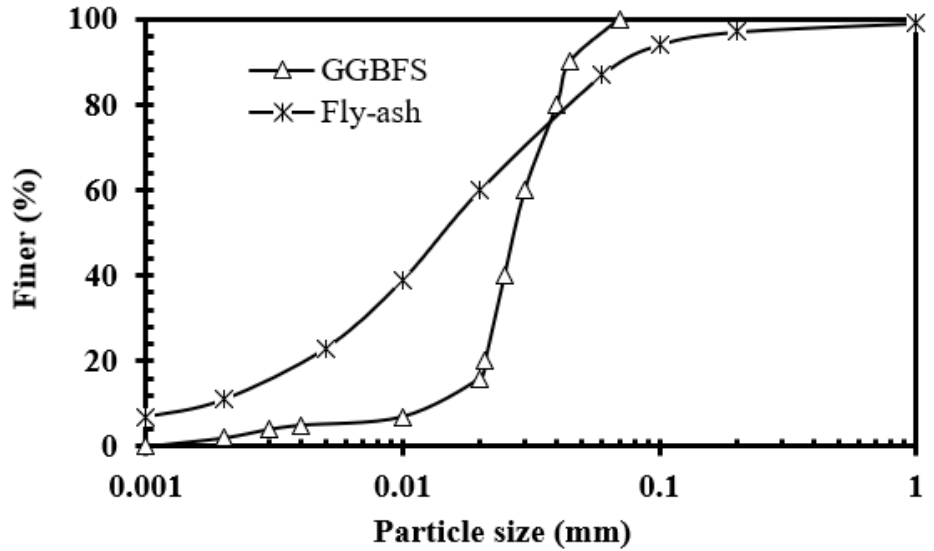
Table 1. Characteristics and classification of kaolin clay used.